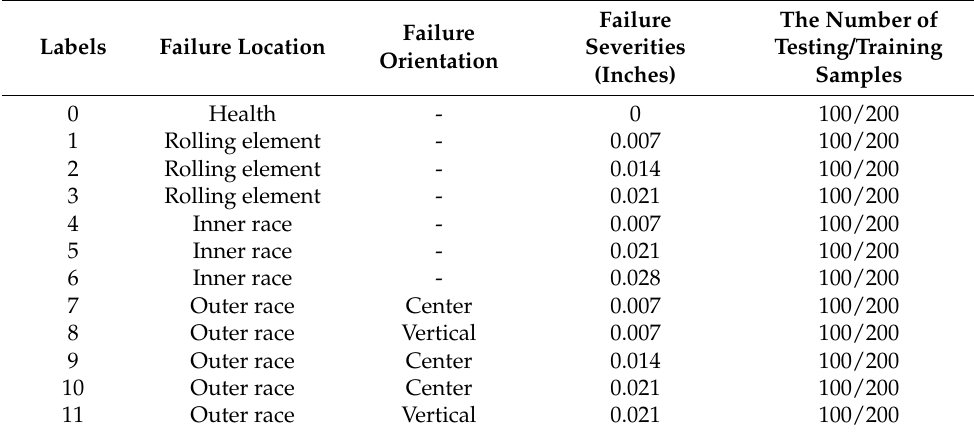
Table 10. The details of the 12 operating states.